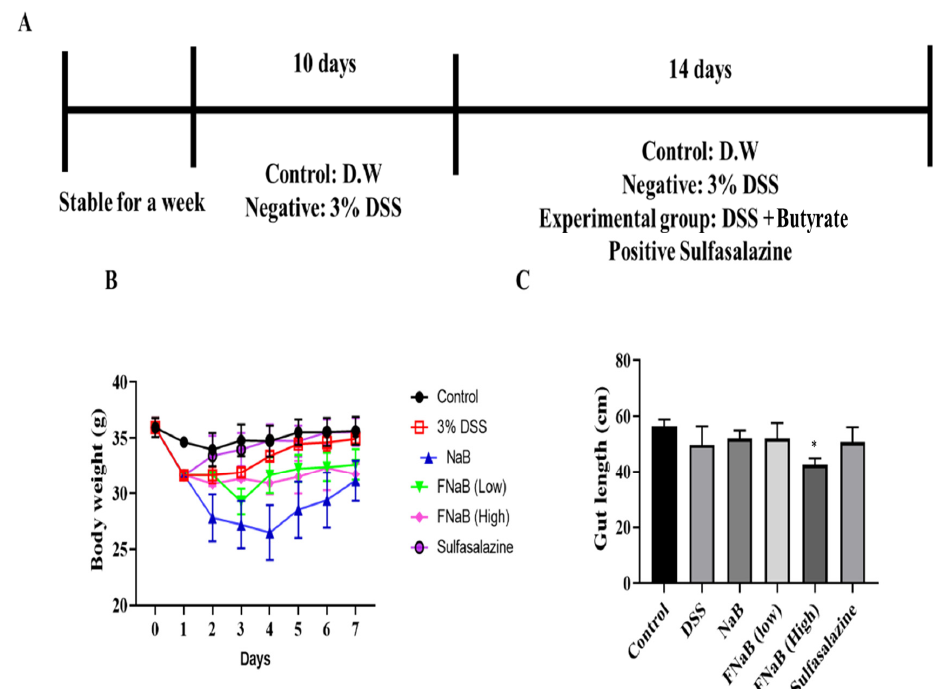
Figure 2. Animal modeling and morphological analysis of FB in DSS-induced colitis mice. ( A ) Schedule of DSS-induced colitis modeling. ( B ) Body weight change of DSS-induced mice. ( C ) Changes in intestinal length in DSS-induced colitis. The histograms were presented as Mean ± SEM, where n = 5. and p -Value less than 0.05 was expressed as statistically significant. * p < 0.05 compared to the DSS group.